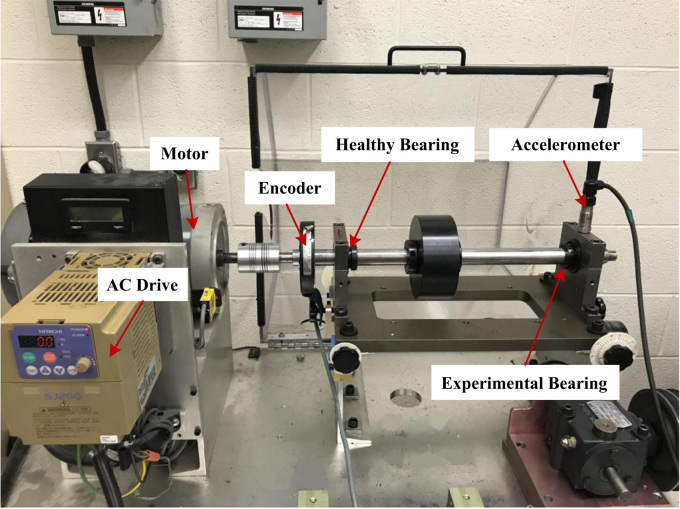
Experimental set-up.